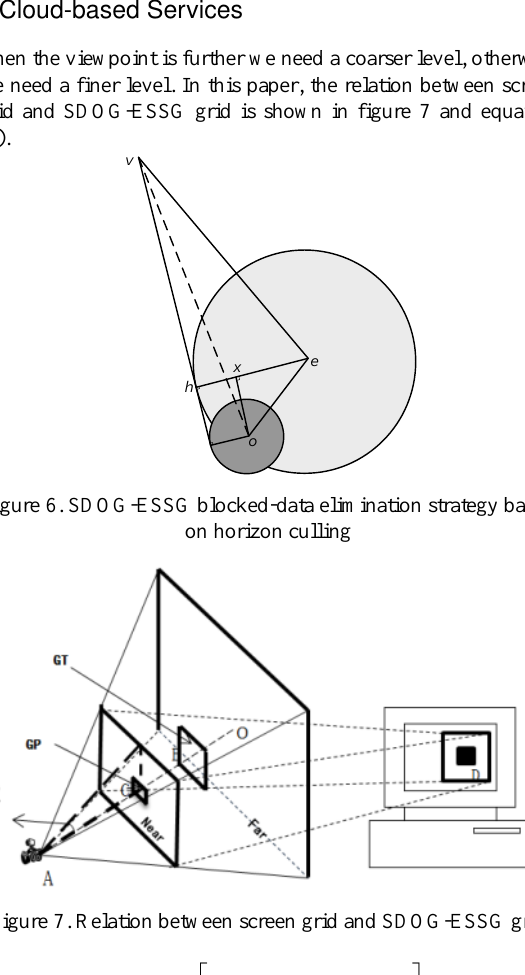
Figure 5. SDOG-ESSG blocked-data elimination strategy based on view-frustum culling